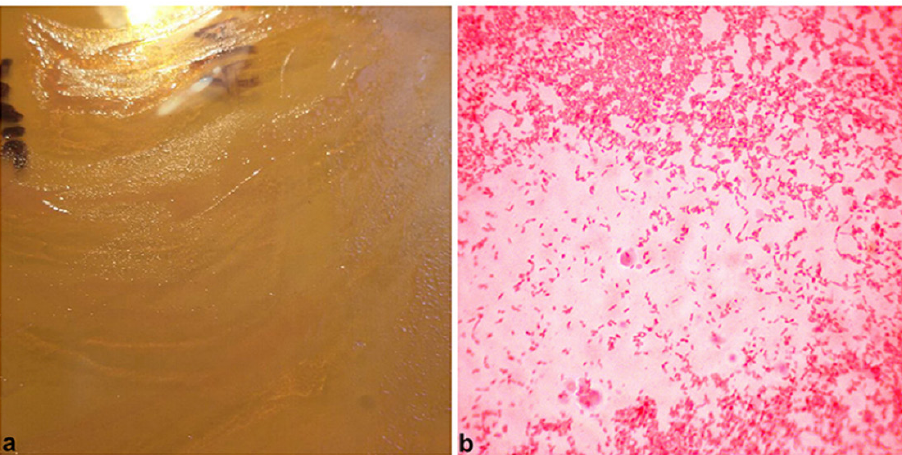
Figure 4: Transparent, rough, wrinkled colonies, cultured from material obtained with sonication of the removed prosthesis (a); Gram stain (400x) reveals small, rod-shaped, gram-negative bacteria